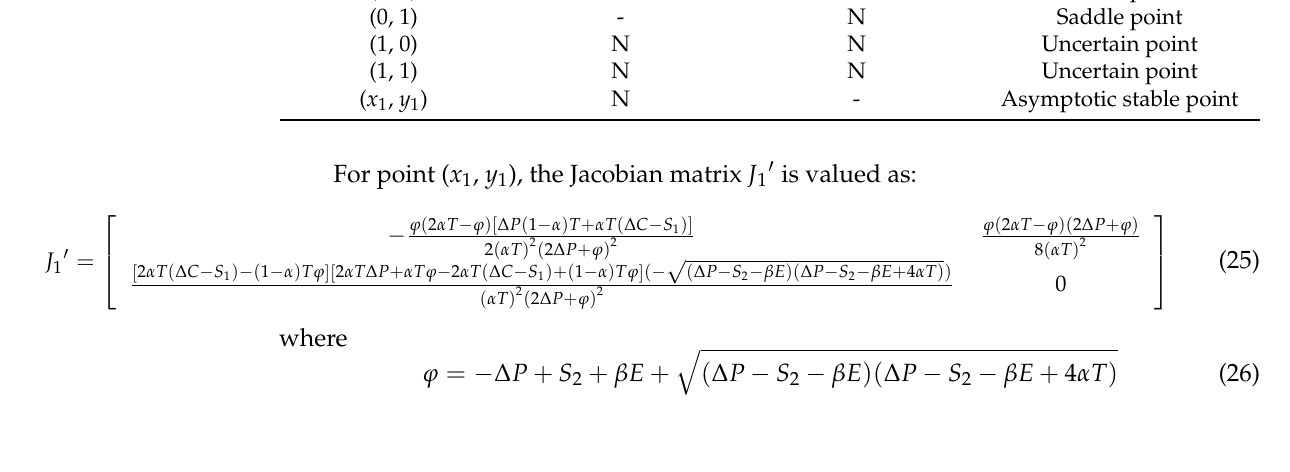
Table 5. Stability analysis of the evolutionary game under the dynamic carbon tax. Equilibrium Point Symbol of det ( J ) Symbol of tr ( J ) Results (0, 0) Saddle point